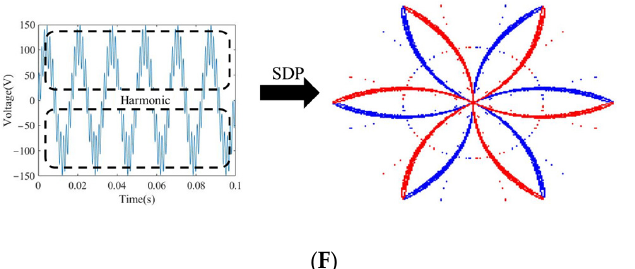
Figure 8. ( A ) Normal energy eigenvalue curve. ( B ) Sag energy eigenvalue curve. ( C ) Swell energy Figure 8 . ( A ) Normal energy eigenvalue curve. ( B ) Sag energy eigenvalue curve . ( C ) Swell energy eigenvalue curve. ( D ) Interruption energy eigenvalue curve . ( E ) Flicker energy eigenvalue curve. eigenvalue curve. ( D ) Interruption energy eigenvalue curve. ( E ) Flicker energy eigenvalue curve. ( F ) Harmonic energy eigenvalue curve. ( F ) Harmonic energy eigenvalue curve.